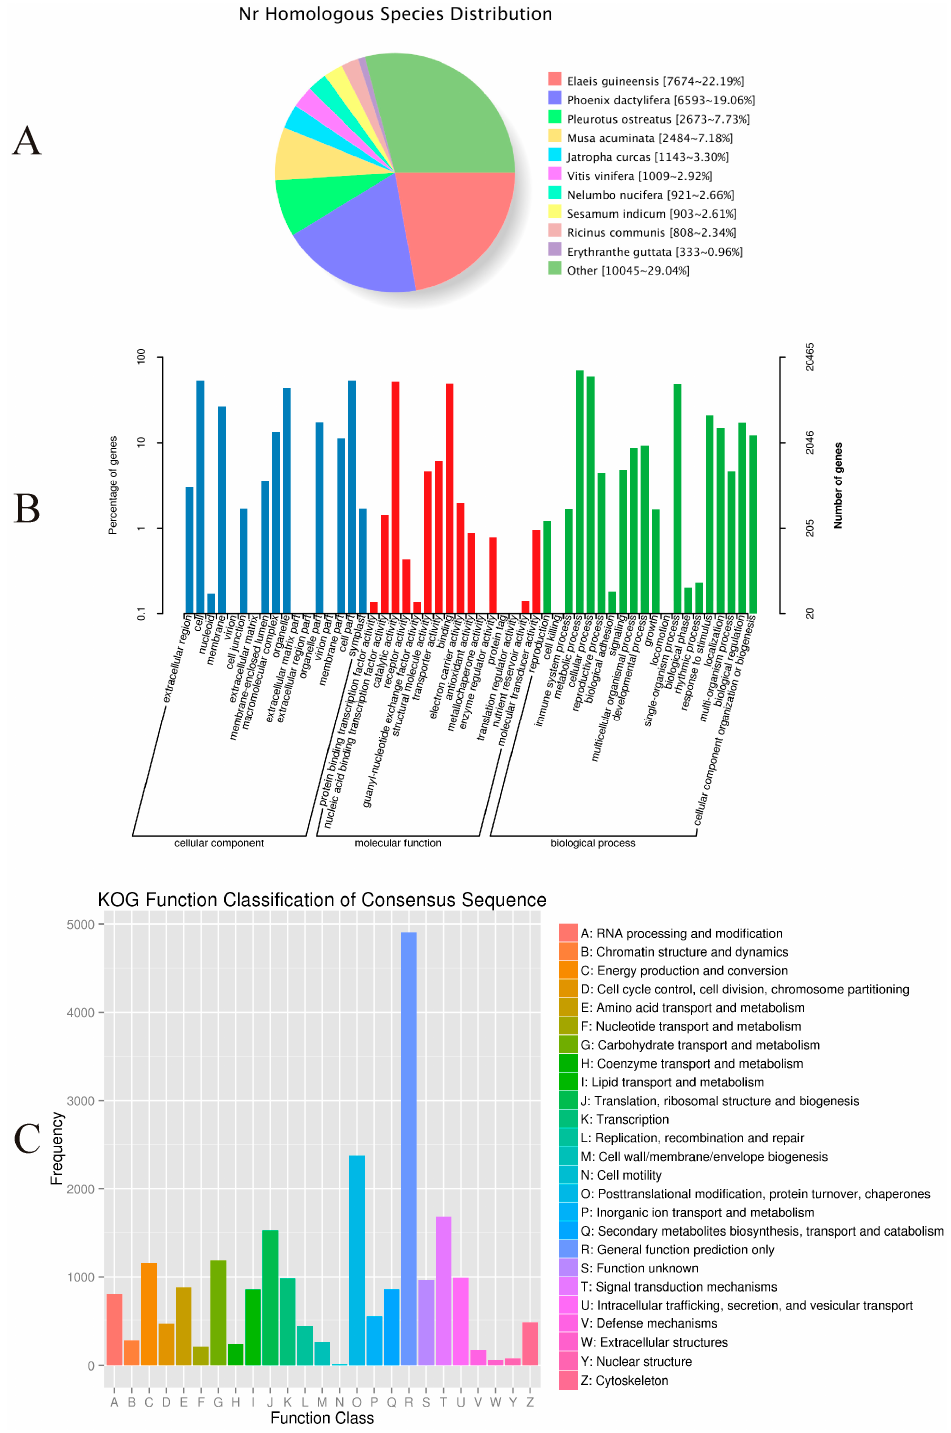
Figure 3. Functional annotations for Polygonatum sibiricum . ( A ) NR classifications of unigenes; ( B ) GO classifications derived via Solexa sequencing; ( C ) COG classifications derived via Solexa sequencing.